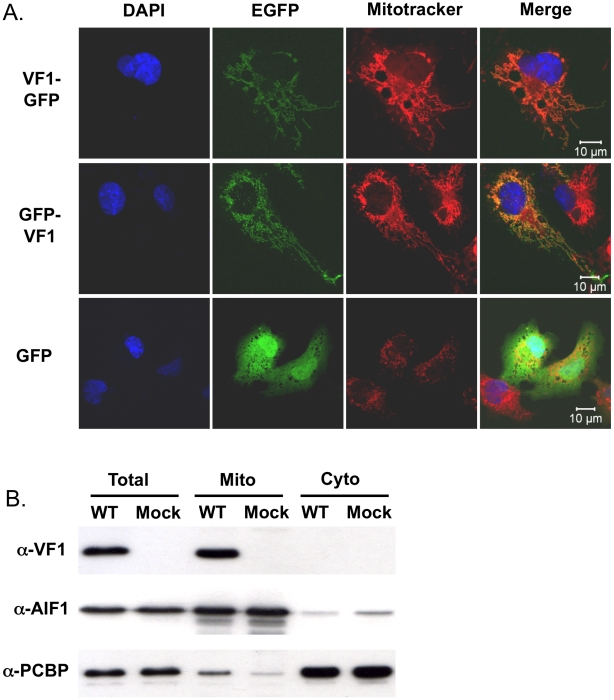
VF1 localizes to mitochondria.(A) Confocal microscopy of cells transfected with either N- or C-terminal fusions of EGFP to VF1. Cos7 cells were transfected with plasmids expressing VF1-EGFP fusion proteins, prior to co-staining with Mitotracker, fixation and staining with DAPI. Cells were analyzed using a Zeiss Meta510 confocal microscope. GFP transfected and Mitotracker stained Cos7 cells are also shown as a control. (B) Biochemical fractionation demonstrates that VF1 localizes to mitochondria during virus infection. RAW264.7 cells were either mock infected or infected with wild-type MNV followed by mitochondrial purification 12 hours post infection. Samples were subsequently analyzed by western blot using antisera to VF1, apoptosis inducing factor 1 (AIF) or poly rC-binding protein1/2 (PCBP). Total cellular lysate was prepared by lysing cells directly in SDS-PAGE sample buffer and run alongside as a control.